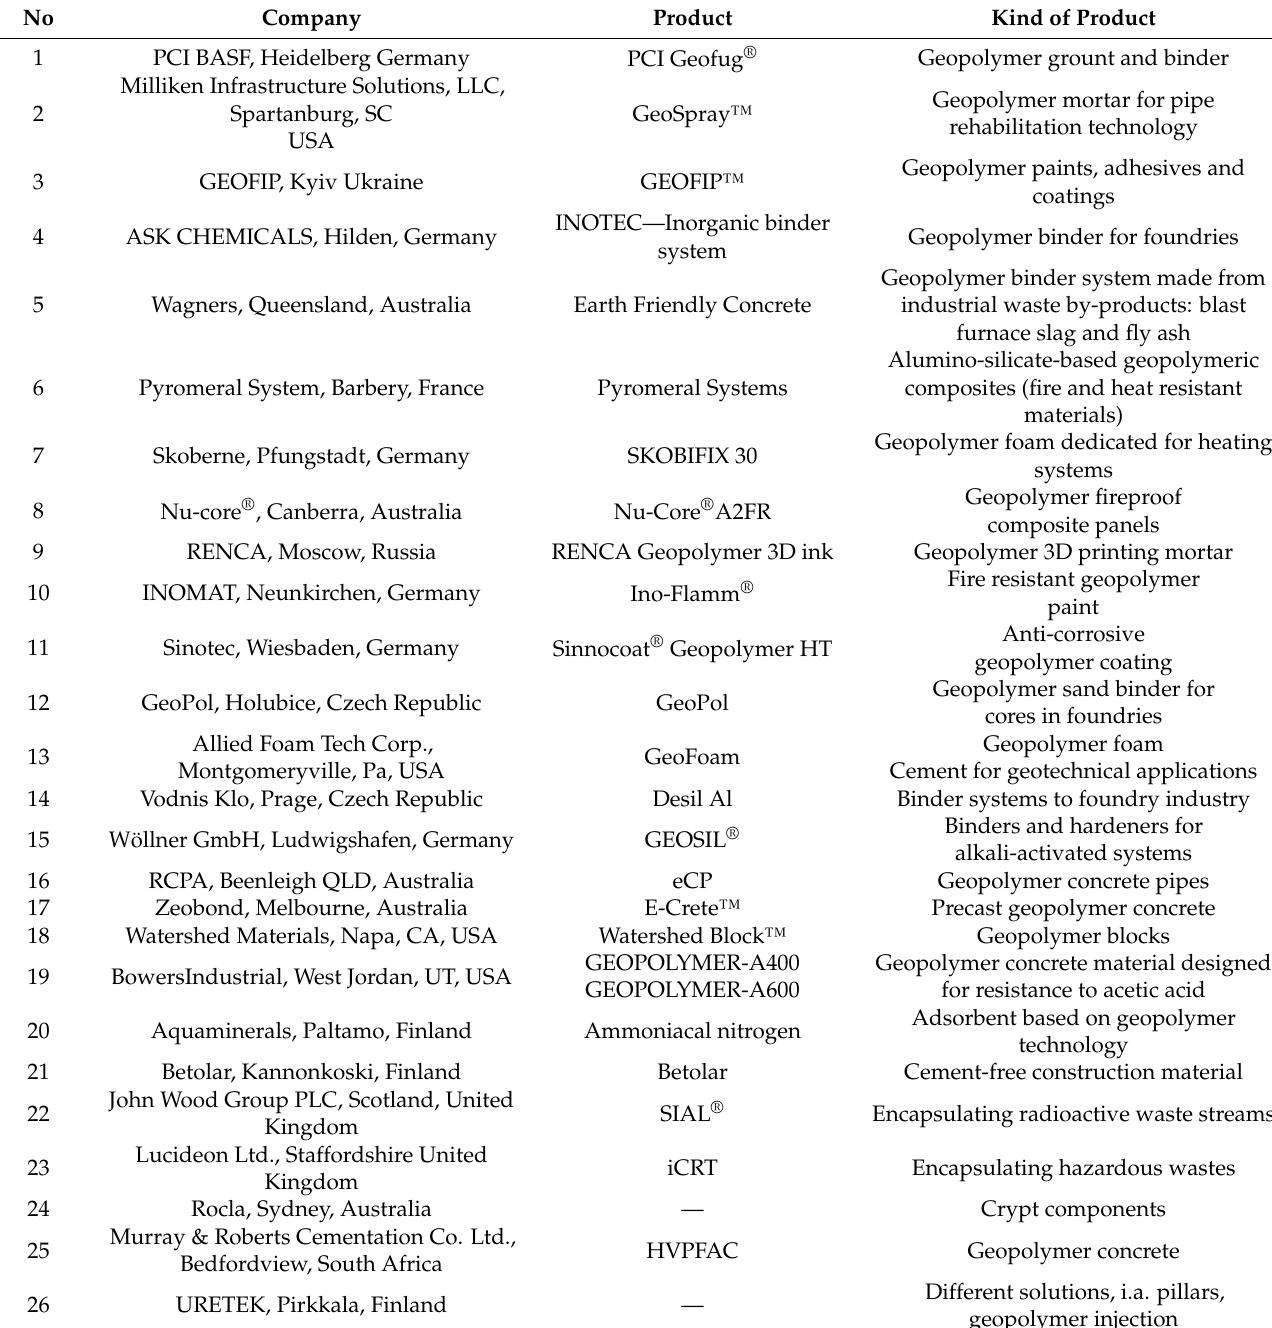
Table 1. Nowadays commercial application of